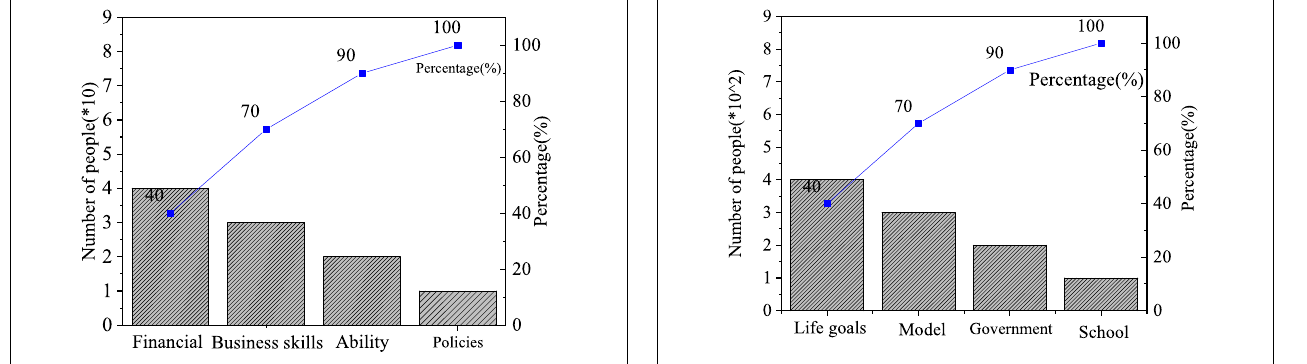
FIGURE 5 | Factors influencing entrepreneurial values.